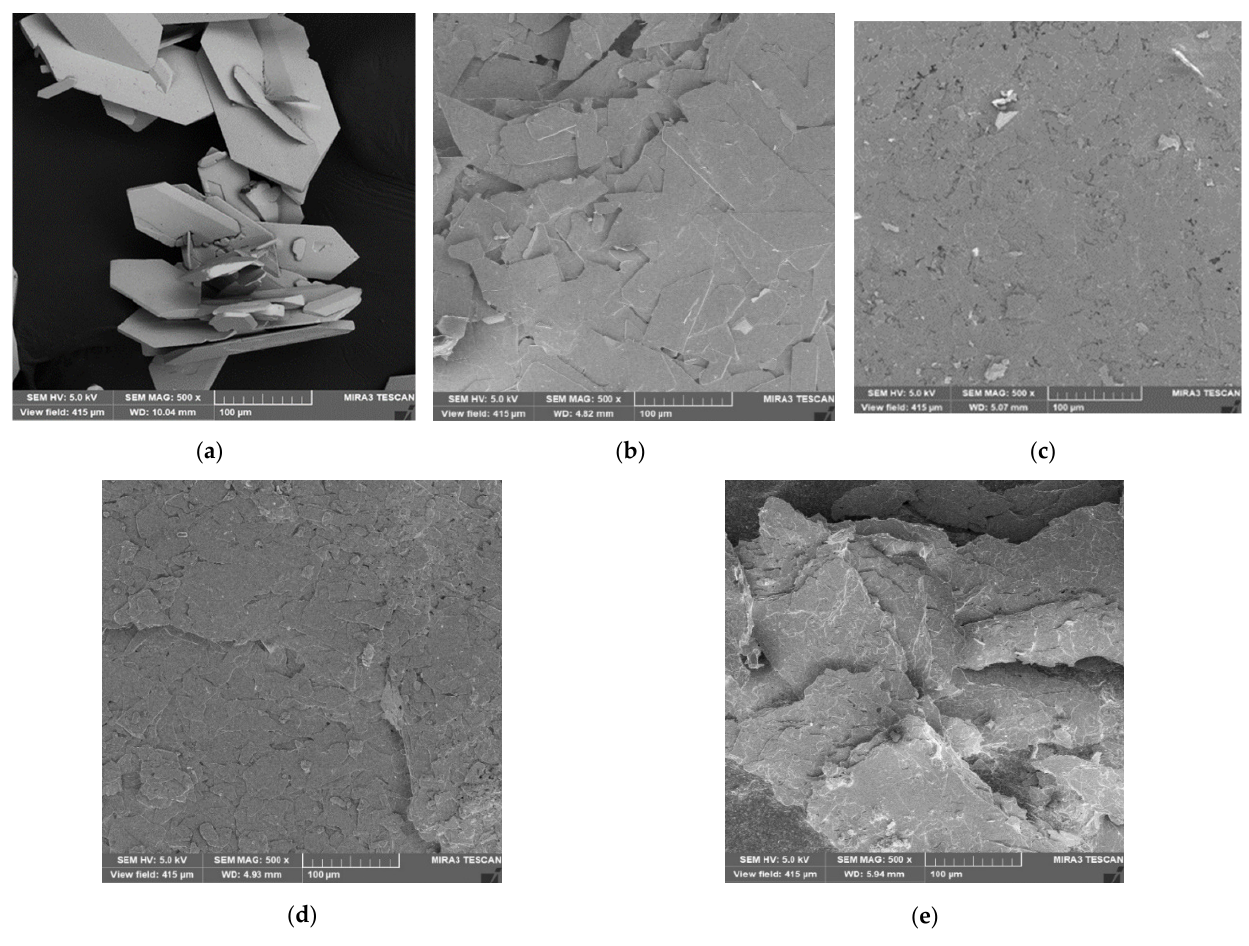
Figure 6. SEM micrographs of Nd 2 (SO 4 ) 3 .8H 2 O product at a magnification of 500 ×. Scale bar of 100 µm ( a ) O/A ratio = 0.6; ( b ) O/A ratio = 0.8; ( c ) O/A ratio = 1.0; ( d ) O/A ratio = 1.2; and ( e ) O/A ratio = 1.4.